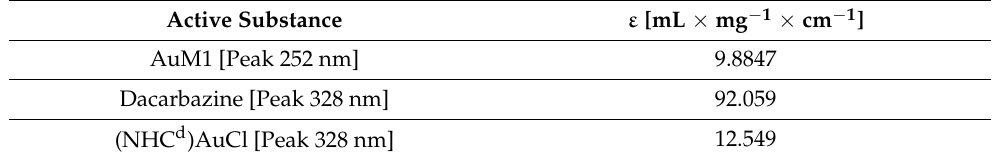
Table 6. Absorptivity of the active substances in PBS